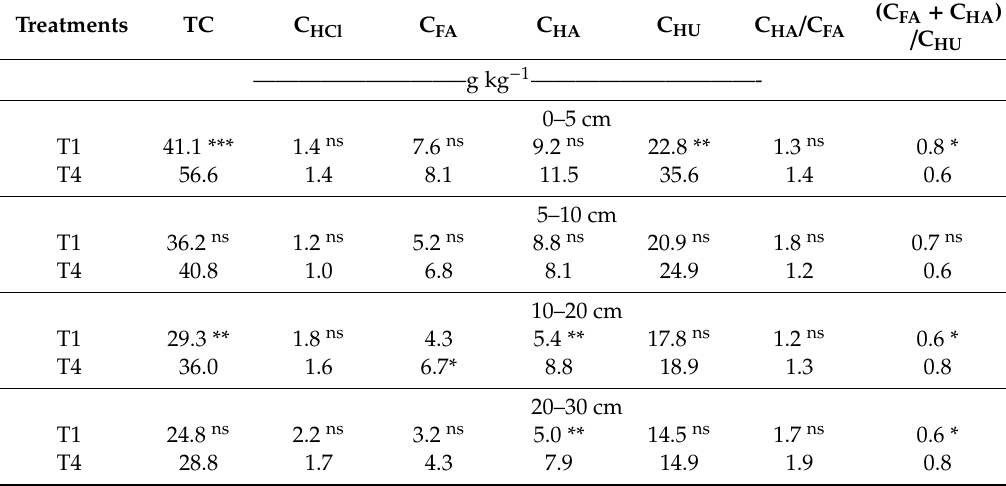
Table 1. Total carbon content (TC), carbon content in the acid extract (C HCl ), fulvic acid (C FA ), humic acid (C HA ), and humin (C HU ), and C HA / C FA and (C FA + C HA ) / C HU ratios of a Cambisol without charcoal (T1) and with charcoal − 40 Mg ha − 1 (T4) application.